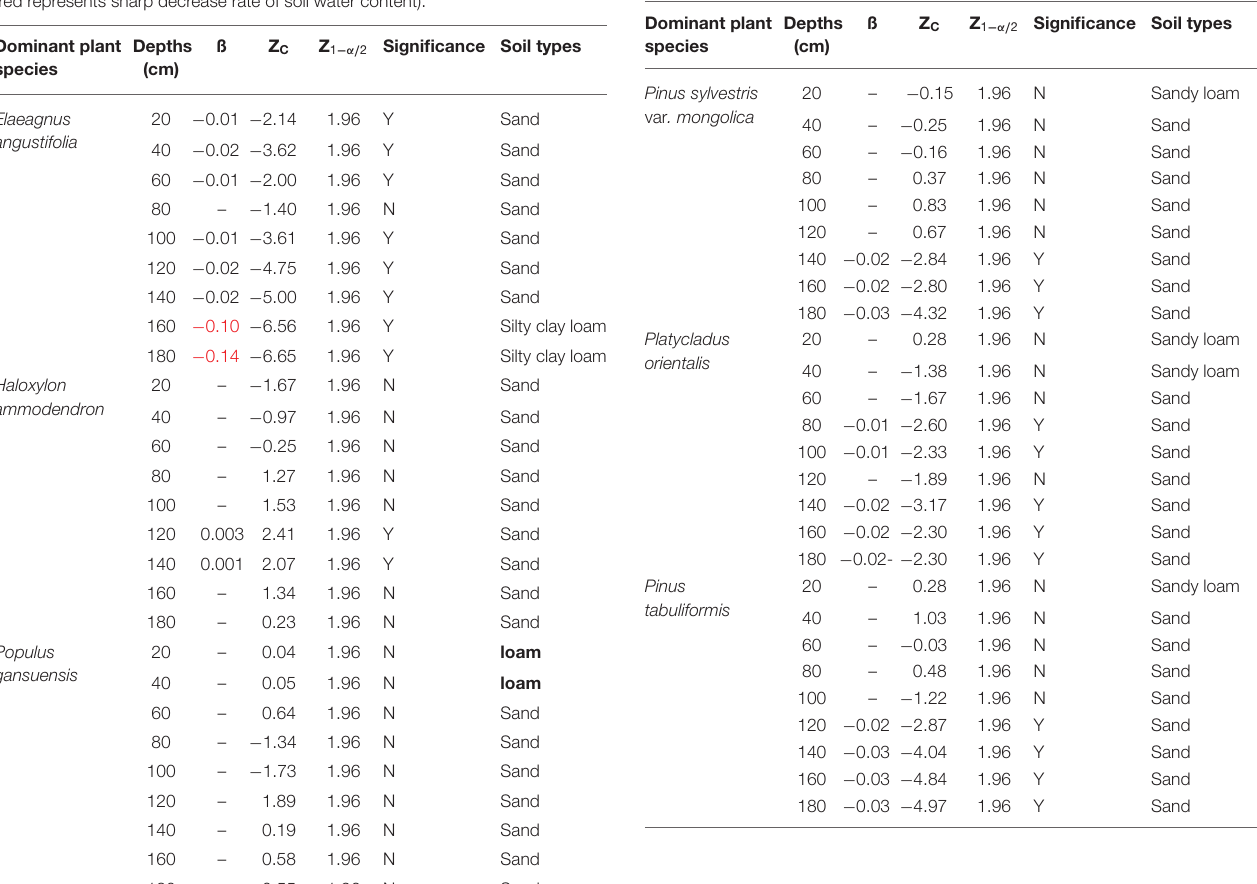
( Table 2 ). In the shrubland of Haloxylon ammodendron and Populus gansuensis , the soil water content at different depths was